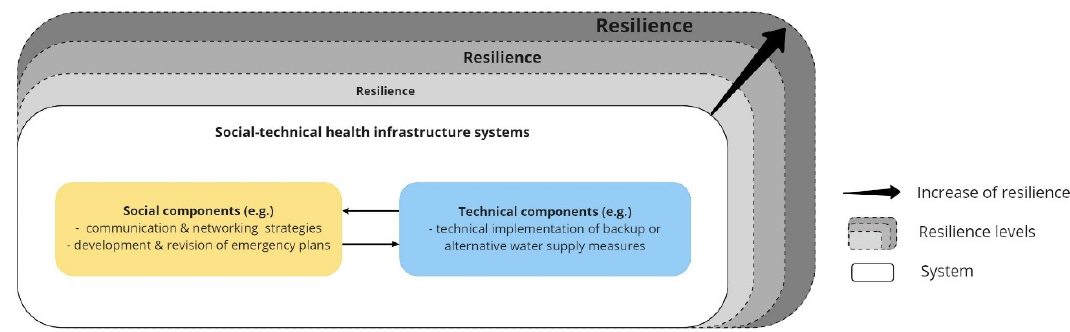
Figure 4. Holistic understanding of social-technical health infrastructure systems by combining interconnected social and technical components essential to increasing resilience.